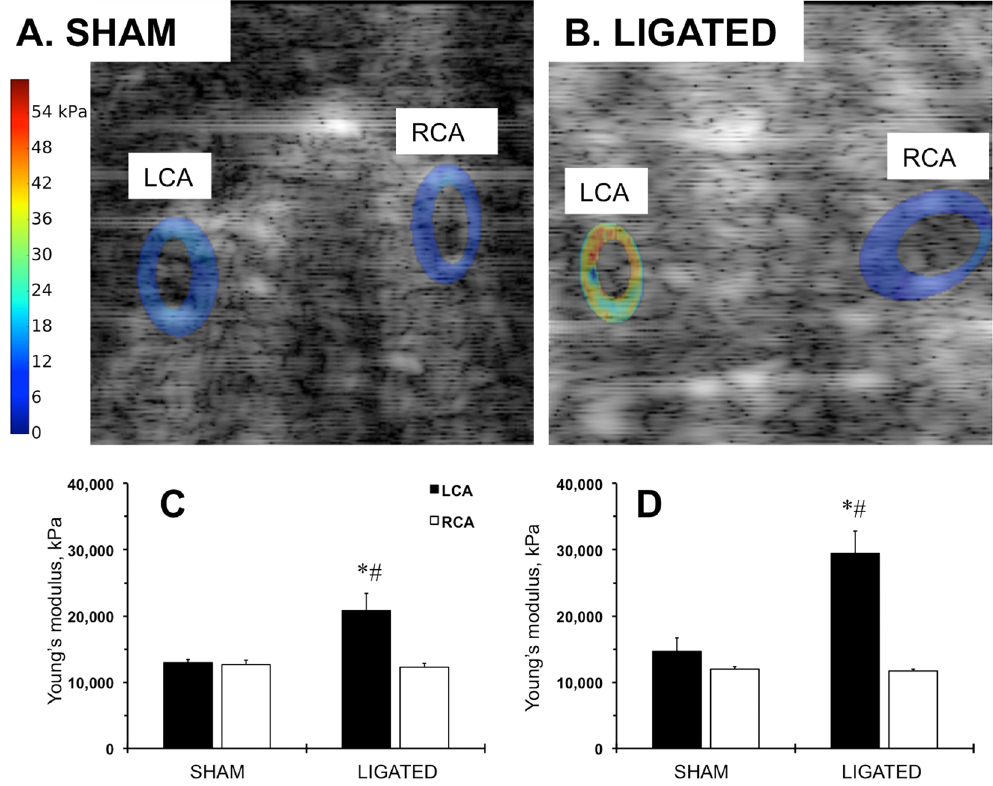
Figure 3. Elastography profiles of the carotid arteries in FVB mice after ligation. ( A ) Computed sonograms of the carotid arteries at 2 weeks after sham operation. ( B ) Computed sonograms of the carotid arteries at 2 weeks after ligation. LCA, left carotid artery. RCA, right carotid artery. The Young’s modulus is color-coded: lowest (zero) is set in blue; highest value (54 kPa) is in red. ( C ) Quantitative analysis of the Young’s modulus at 1 week post-surgery. ( D ) Quantitative analysis of the Young’s modulus at 2 weeks post-surgery. Black bars – LCA. Open bars – RCA. SHAM and LIGATED mice are shown on X-axis. Values are mean ± SEM. * p < 0.05 vs. LCA, SHAM. # p < 0.05 vs. RCA, LIGATED. n = 5 per